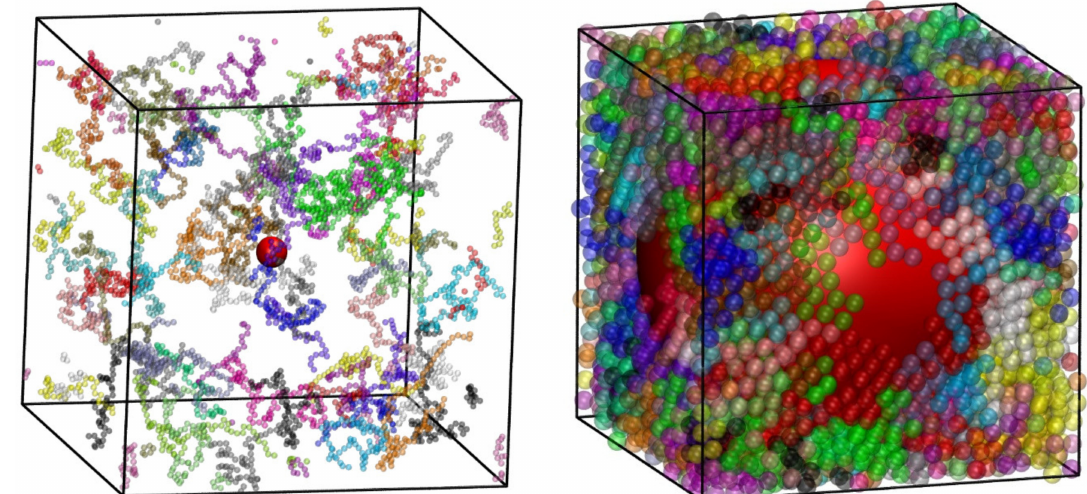
Figure 12. System snapshots of polymer nanocomposite ( N = 100, N ch = 48) at different effective packing density, ϕ eff . The nanofiller, shown in red, corresponds to a single, impenetrable sphere with diameter d sph (in units of σ ) whose center is located at the center of the simulation cell: ( left ) ϕ eff = 0.01, d sph = 5 and ( right ) ϕ eff = 0.55, d sph = 20. Monomers are colored according to the parent chain and are shown as semitransparent spheres for clarity. Image created with the VMD visualization software [54]. Figure panels are also available as interactive, 3-D images in Supplementary Materials.